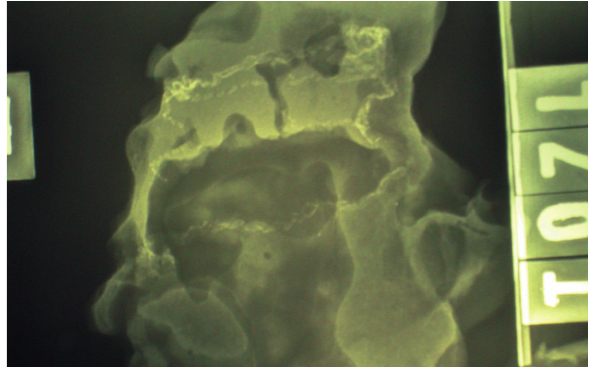
Fig. 1 - Aspecto radiológico de prótese preservada em L-Hydro® (ausência de calcificação)